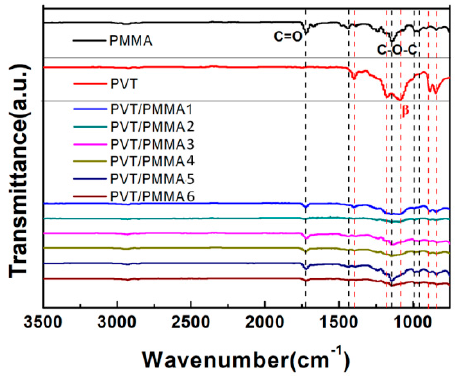
Figure 5. FTIR transmission spectra of pure P(VDF-TrFE), PMMA films, and PVT/PMMA composite films.